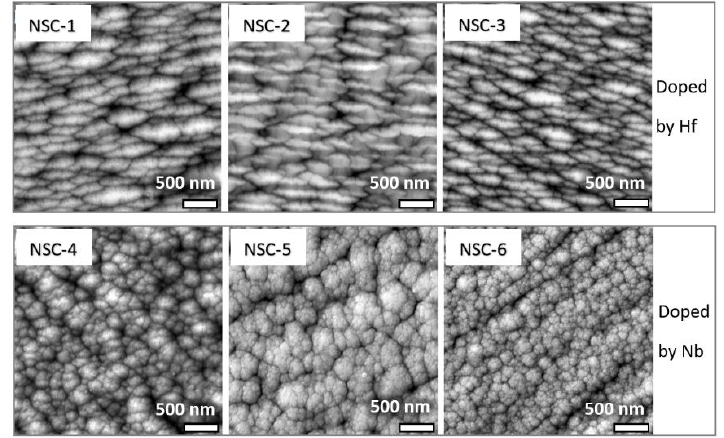
Figure 2. SEM surface micrographs (plan view) of the NSC samples doped by Hf (top panel with NSC-1, NSC-2, and NSC-3) and doped by Nb (bottom panel with NSC-4, NSC-5, and NSC-6). Images show identical morphology for all three samples having the same doping element.